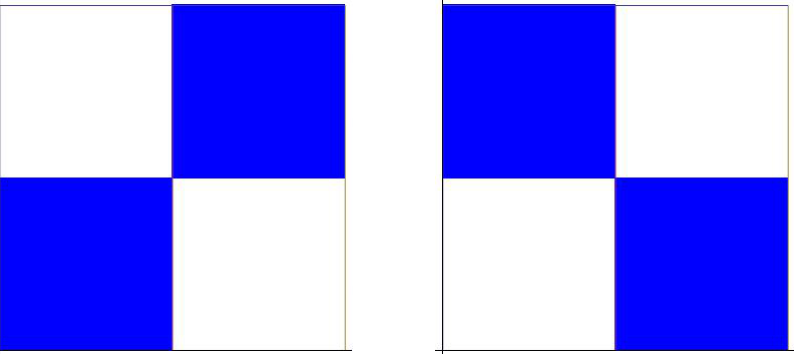
Figure 15. Distributions with two different orientations for the case no mixing-no mixing. Positive orientation is shown in the left and negative one is in the